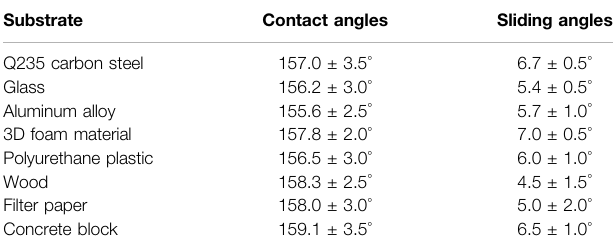
TABLE 2 | Water contact angles and sliding angles of the obtained superhydrophobic coating on different substrates. Substrate Contact angles